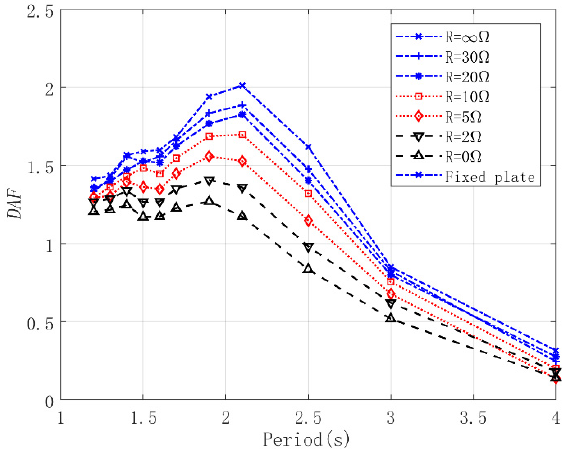
Figure 22. The dynamic amplification factor ( DAF ) values of related motion of THP1 with different tuned periods and LRs.